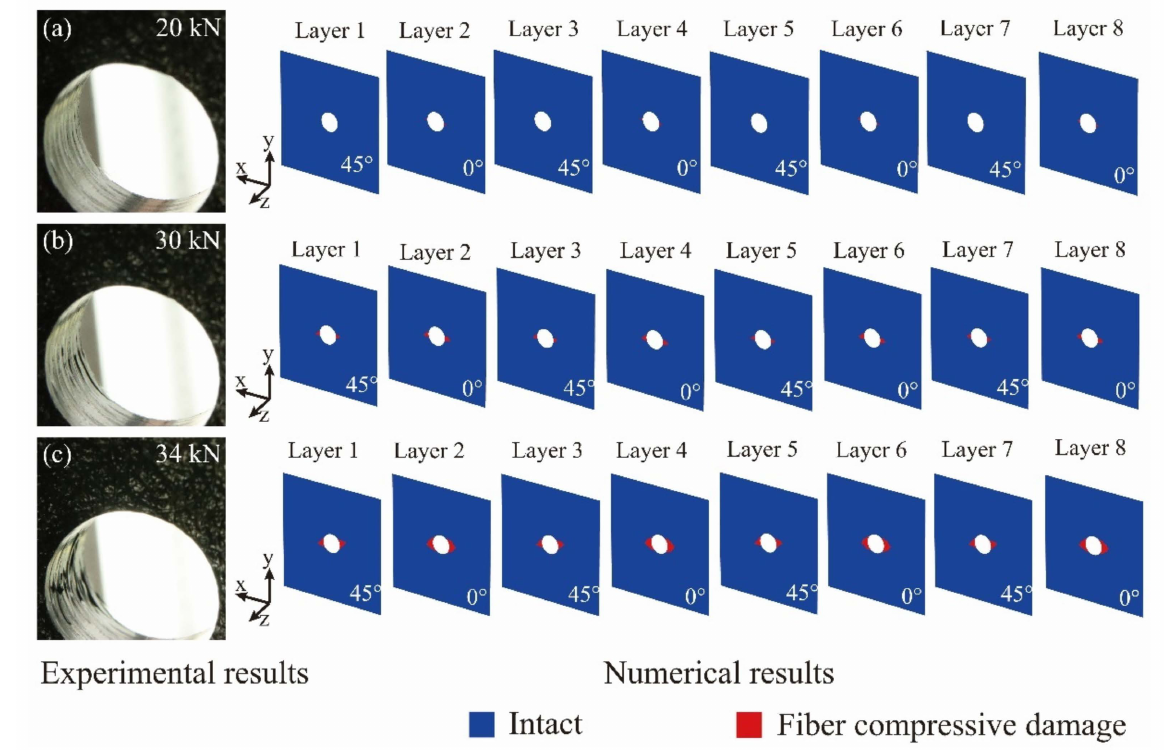
Figure 19. Comparison of the experimental and numerical damage statuses of the open-hole fabric laminate under different compression loads: ( a ) the compression load of 20 kN; ( b ) the compression load of 30 kN; ( c ) the compression load of 34 kN.